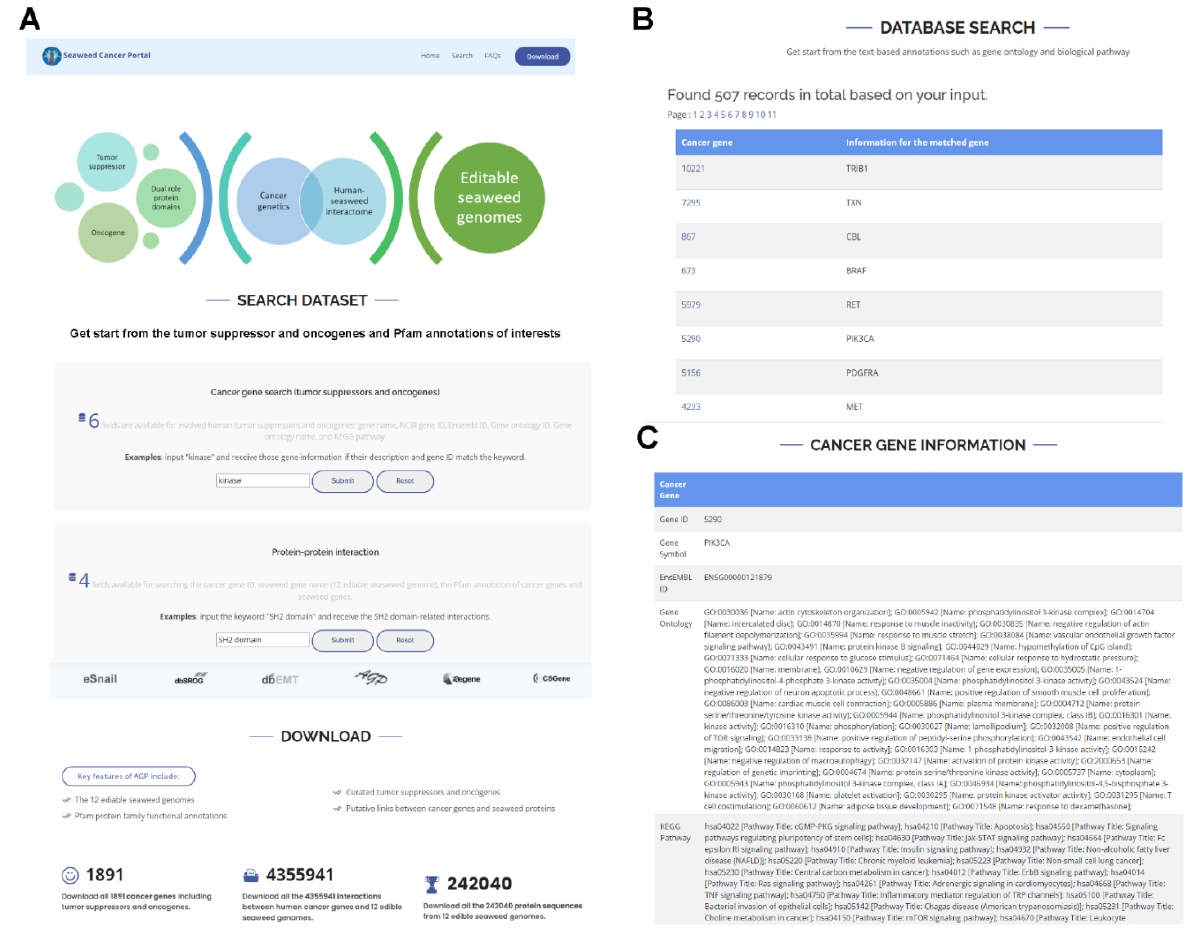
Figure 2. A web browsing interface for the interactome between human cancer genes and twelve edible seaweed genomes. ( A ) The homepage includes the data search interface, and the data download links. ( B ) The search result will guide the user to each cancer-related gene page. ( C ) On each gene page, we provide basic annotation information, such as gene ontology and KEGG pathway of the cancer genes.